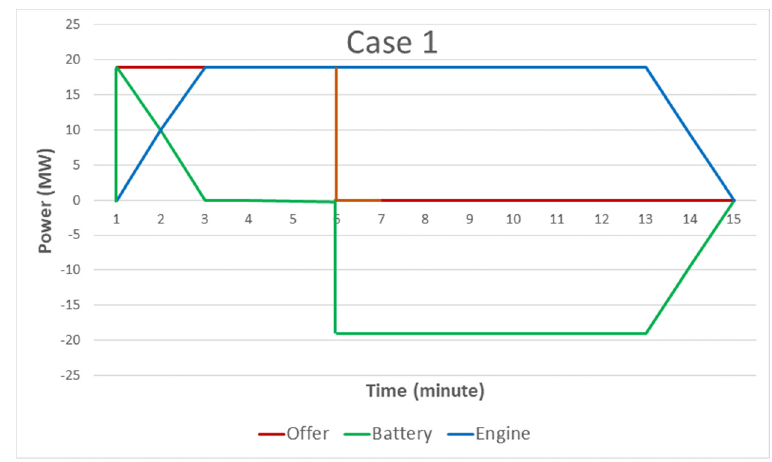
Figure 7. Example operation—case 1.